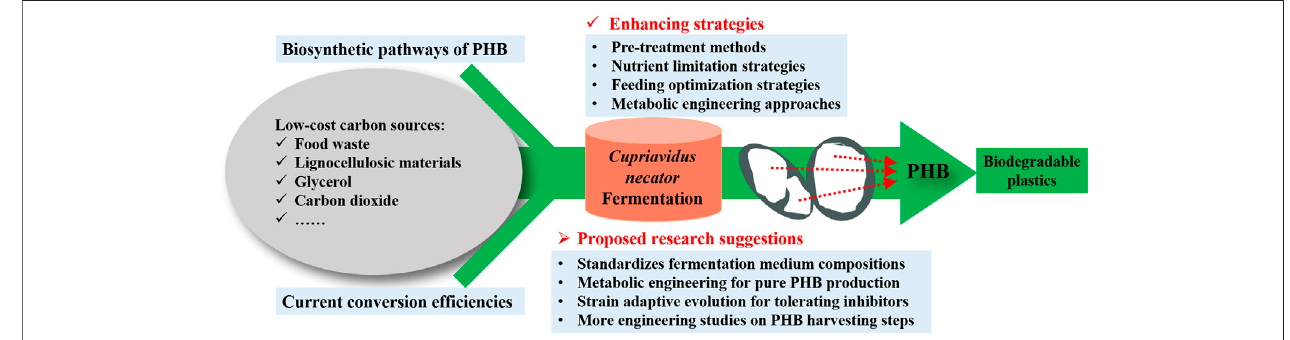
FIGURE 2 | Proposed suggestions for further increase of the PHB yield and productivity from C. necator fermentation.